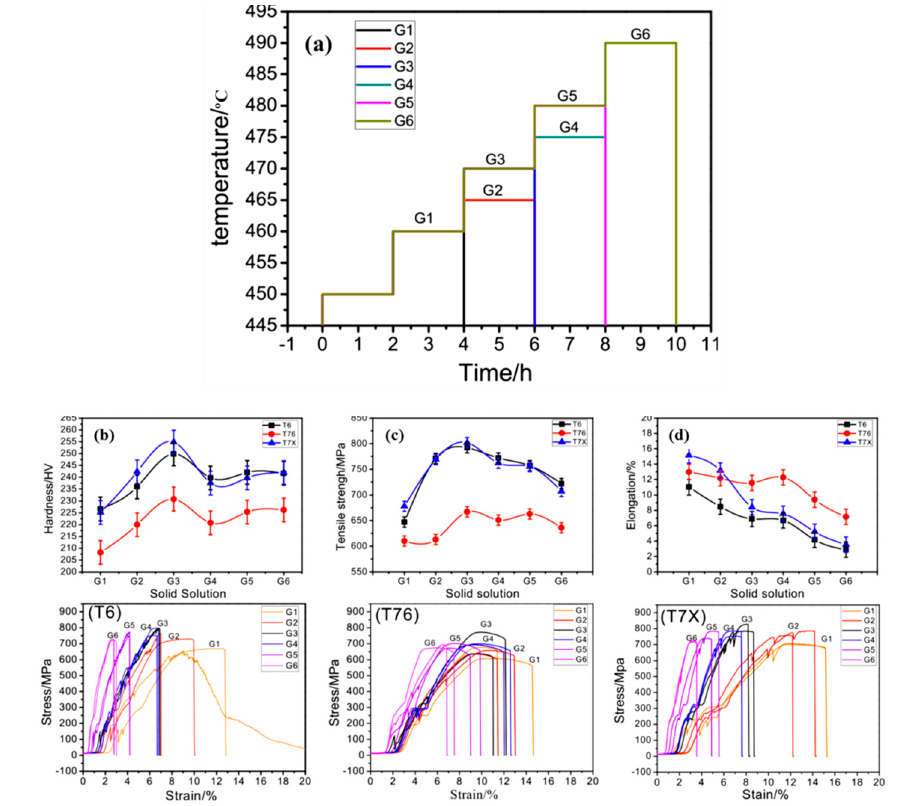
Figure 10. ( a ) Schematic diagram of solution process; Mechanical properties of alloys: ( b ) hardness, ( c ) tensile strength, ( d ) elongation and the corresponding stress-strain curves under T6, T73, T7X aging. (Reprinted with permission from ref. [103]. Copyright 2019 Elsevier).